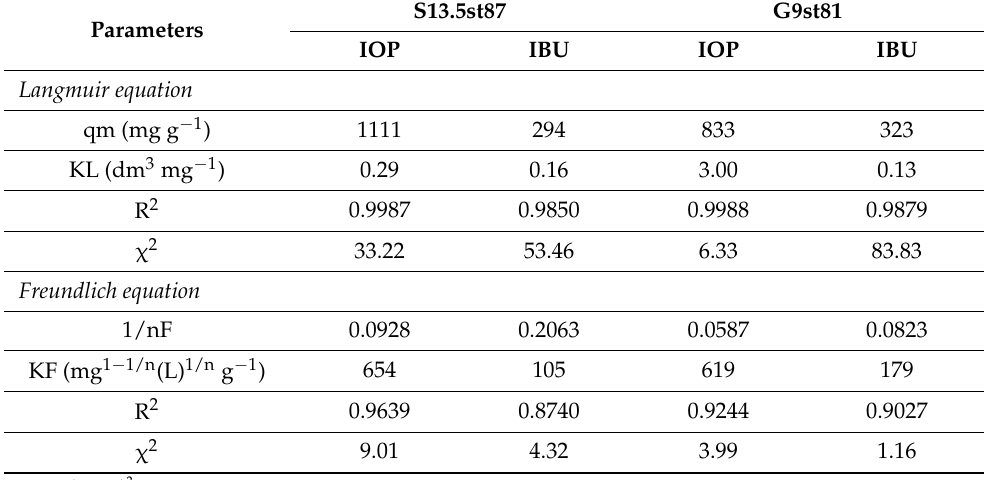
Table 5. Parameters of the equilibrium isotherm models of activated carbon